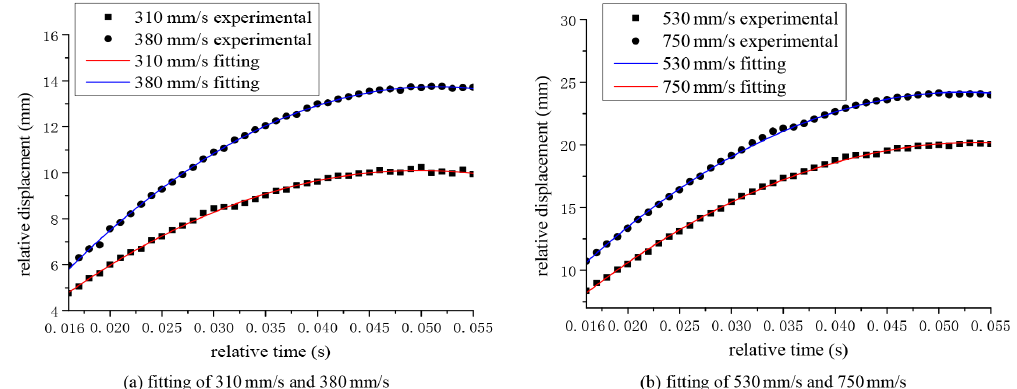
Figure 11. Displacement fitting curves in the locking braking strategy.